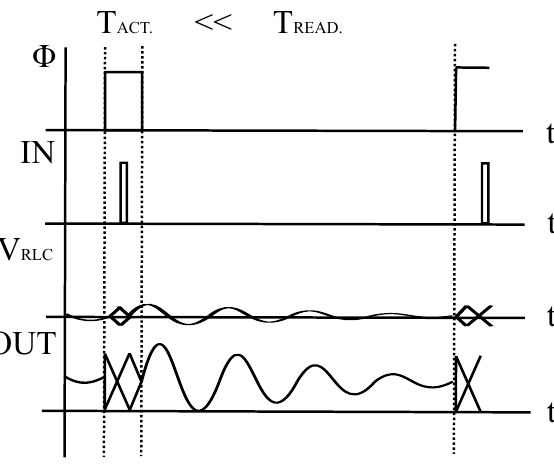
Figure 8. Waveforms for an ideal Bidirectional